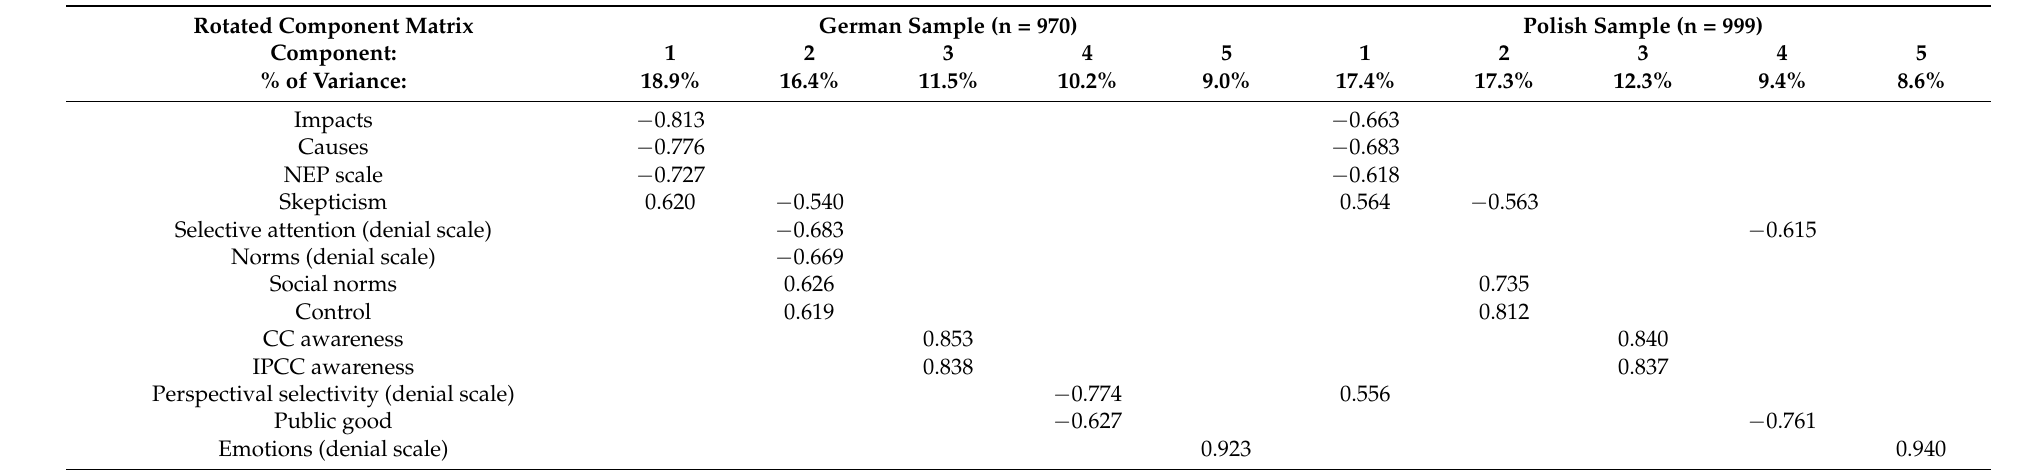
Table 4. Factor analysis of variables included in the research. Table displays rotated component matrix; coefficients below 0.5 are not shown. Rotated Component